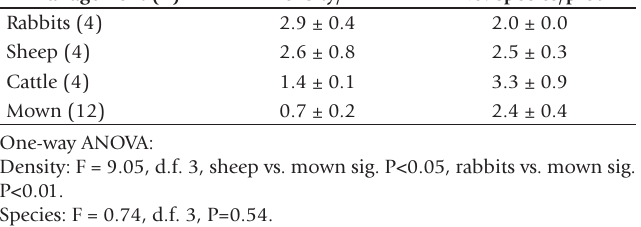
Fig. 8. Sheep-grazed area (left) vs. undisturbed area (right); credit T. Gardiner.